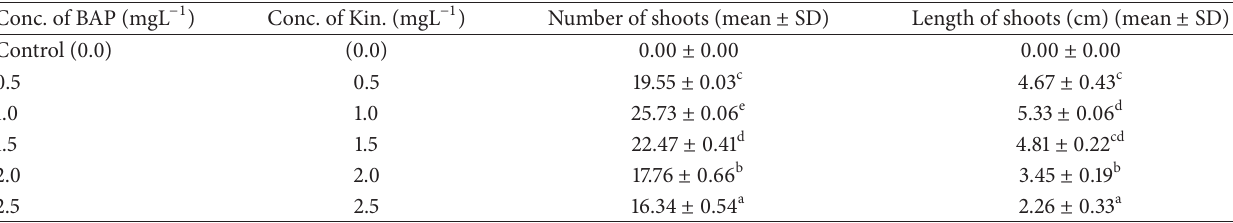
Table 2: Effect of cytokinins (BAP and Kin) after 4 weeks on multiplication of shoots. Conc. of BAP (mgL −1 ) Conc. of Kin. (mgL −1 ) Number of shoots (mean ± SD) Length of shoots (cm) (mean ± SD) Control (0.0) (0.0) 0.00 ± 0.00 0.00 ± 0.00 0.5 0.5 19.55 ± 0.03 c 1.0 1.0 1.5